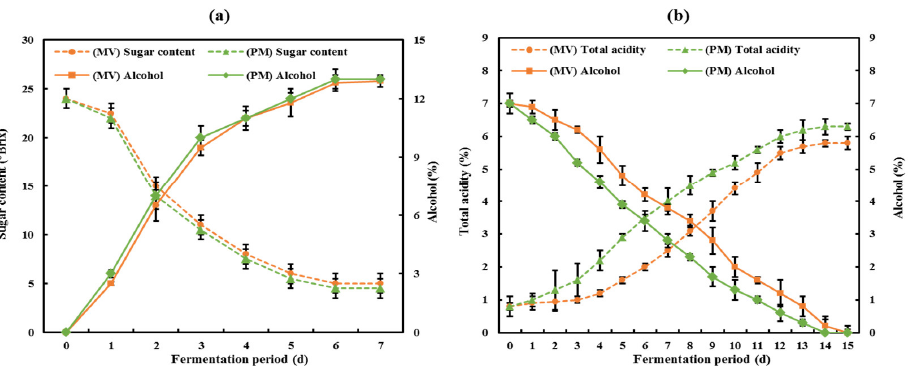
Figure 1. The two-stage fermentation for the production of MV and PMV vinegars. ( a ) Changes in sugar and alcohol content during alcohol fermentation. ( b ) Changes in alcohol content and total acidity during acetic acid fermentation. Data are expressed as mean ±